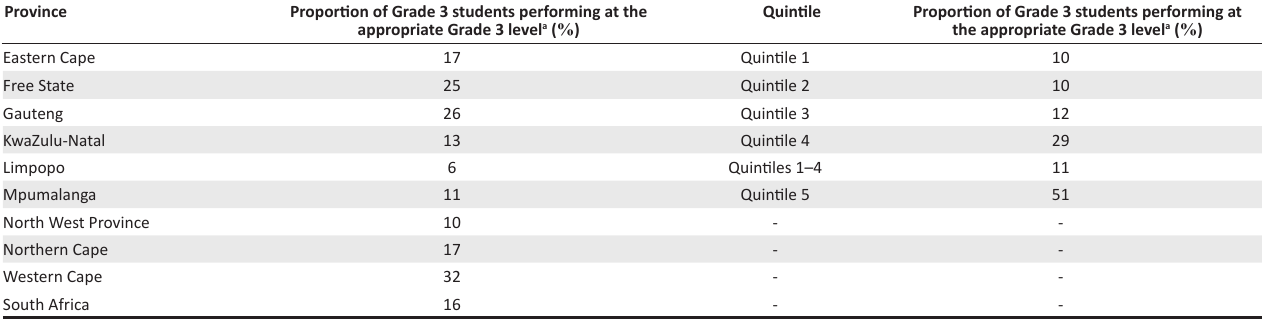
TABLE 2: Proportion of Grade 3 students performing at the Grade 3 level by province and student quintile (Systemic Evaluation 2007). Province Proportion of Grade 3 students performing at the appropriate Grade 3 level a ( % )